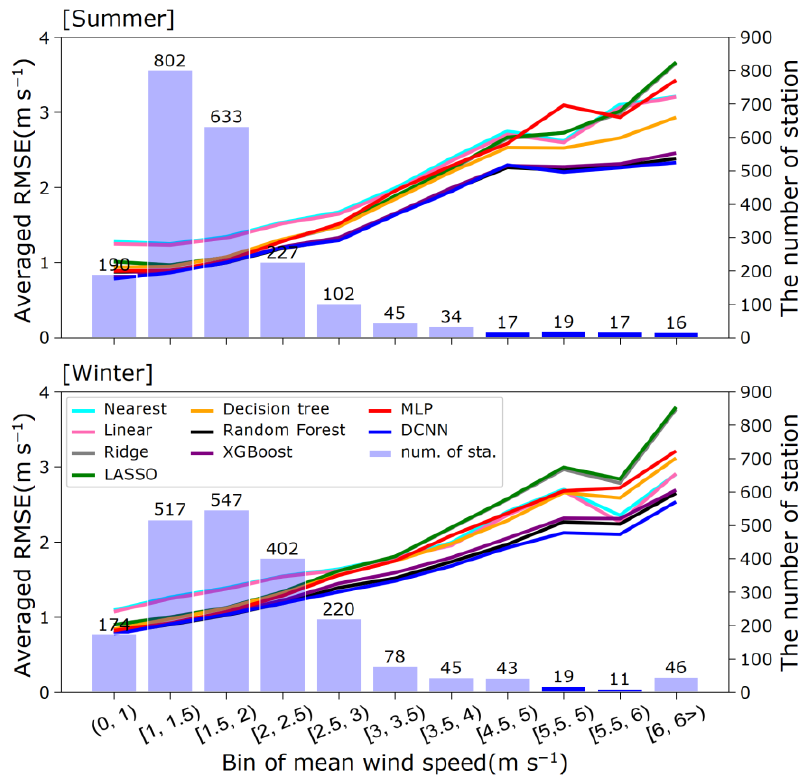
Figure 12. Comparison of errors in estimation of wind speed at sites with different average WS 10 . Bars show the number of sites with WS 10 within each interval, and lines show the average RMSE of winter and summer wind speeds estimated using each method for the corresponding interval.